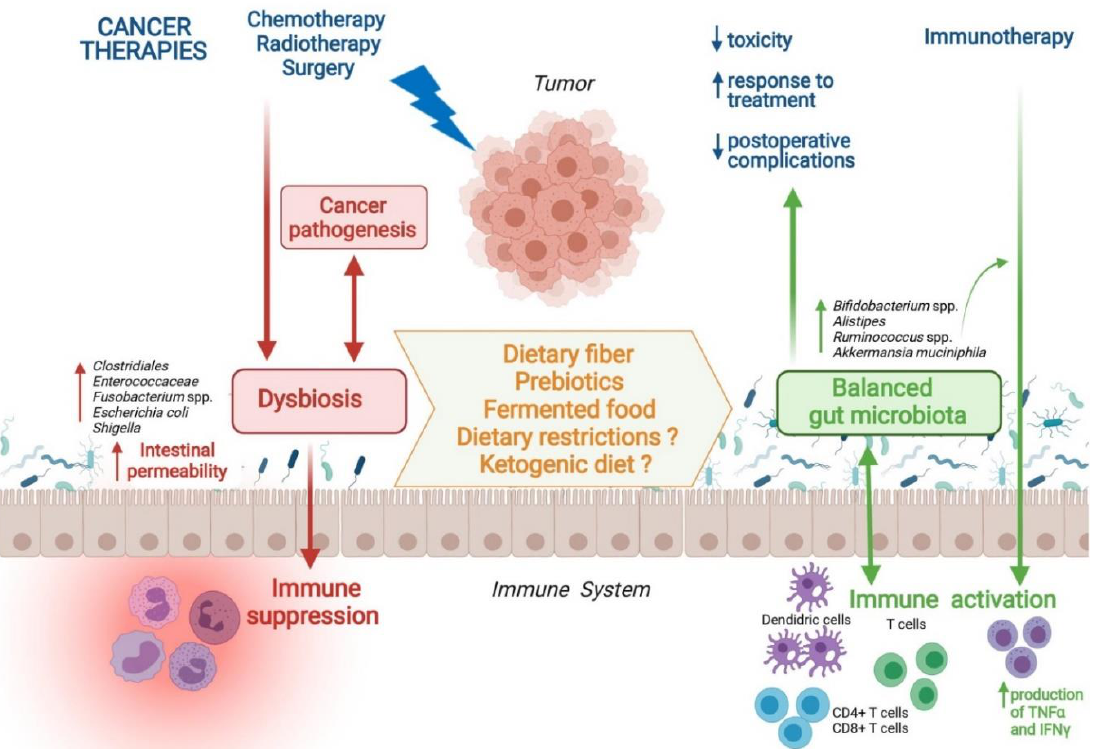
Figure 1. Nutritional Interventions Modulating Gut Microbiota and Clinical Outcomes during Cancer Therapy. Abbre-